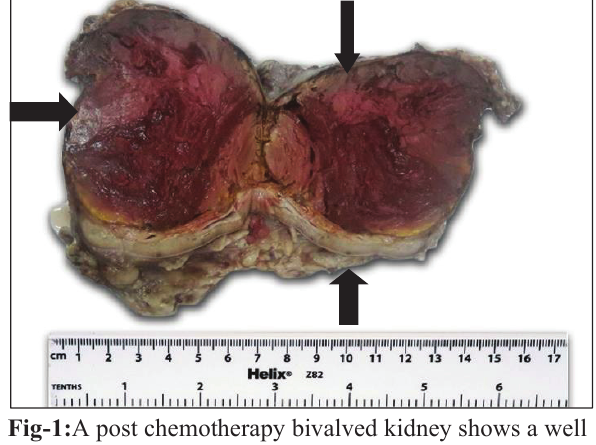
Fig-1: A post chemotherapy bivalved kidney shows a well circumscribed tumor with mahogany cut surface (down & right arrow), and periphery shows thin rim of normal renal parenchyma (up arrow)